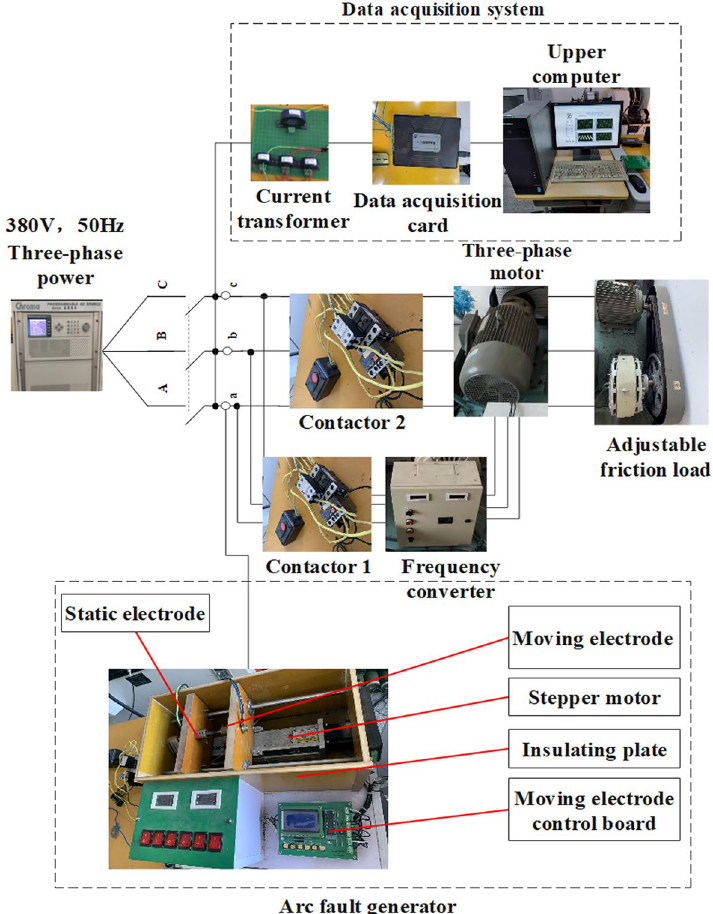
Figure 1. Electrical connection